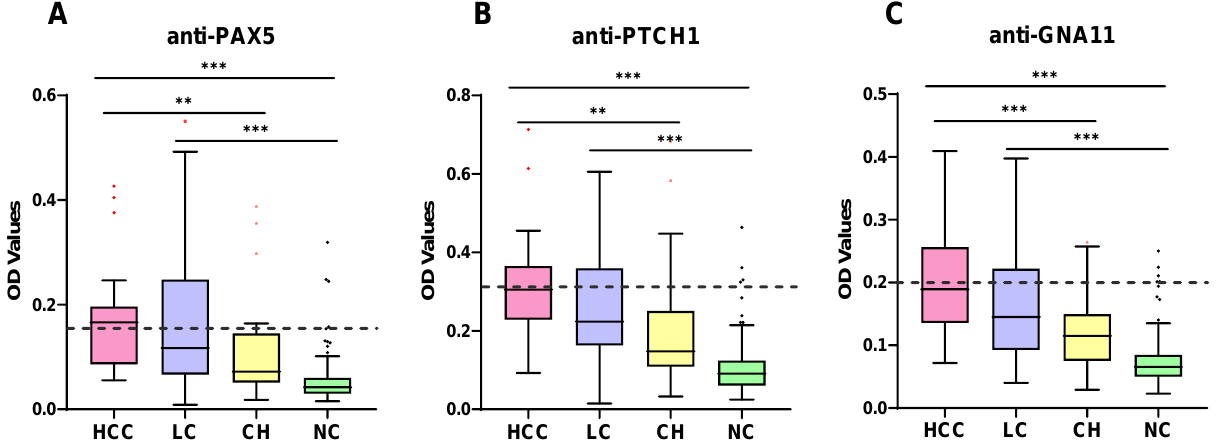
Figure 1. Expression of autoantibodies to PAX5 ( A ), PTCH1 ( B ), and GNA11 ( C )in different subjects including HCC patients, high-risk patients (LC and CH), and normal controls. HCC, hepatocellular carcinoma; LC, liver cirrhosis; CH, chronic hepatitis; NC, normal controls. Cut-off values of individual autoantibodies are indicated by dotted lines. **, p < 0.01; ***, p < 0.001. After we set the constraints on the positive number of control subjects to less than 5%, as shown in Figure 2A, there are 52.0% of HCC sera with positive autoantibody reaction to PAX5, which is significantly higher than those of the CH sera (22.2%) and NC (4.7%) groups. Additionally, autoantibodies to PTCH1 and GNA11 are detected in 44.0% HCC sera, which are significantly higher than those in CH sera (18.5% to GNA11, 14.8% to GNA11) and NC sera (4.7%). The frequencies of autoantibodies to PAX5, PTCH1, and GNA11 in the LC group are 32.1%, 35.7%, and 25.0%, which are significantly higher than their frequencies in the CH and NC groups (Figure 2B,C). There is no statistical significance observed in frequencies of any of three autoantibodies between the HCC and LC groups, but when a parallel test is performed to combine the three autoantibodies, 68.0% of the HCC patients are identified, which is significantly higher than the LC (39.3%), CH (22.2), and NC (5.9%) groups (Figure 2D). Additionally, the frequency of the combination of those three autoantibodies in the LC group is higher than that in the NC group; there is no significant difference observed in the frequency between the CH and NC groups (Figure